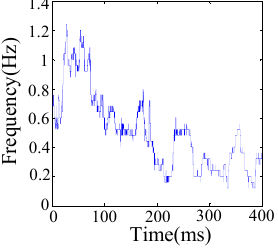
Figure 15. Wavelet ridge for improved wavelet scalogram.